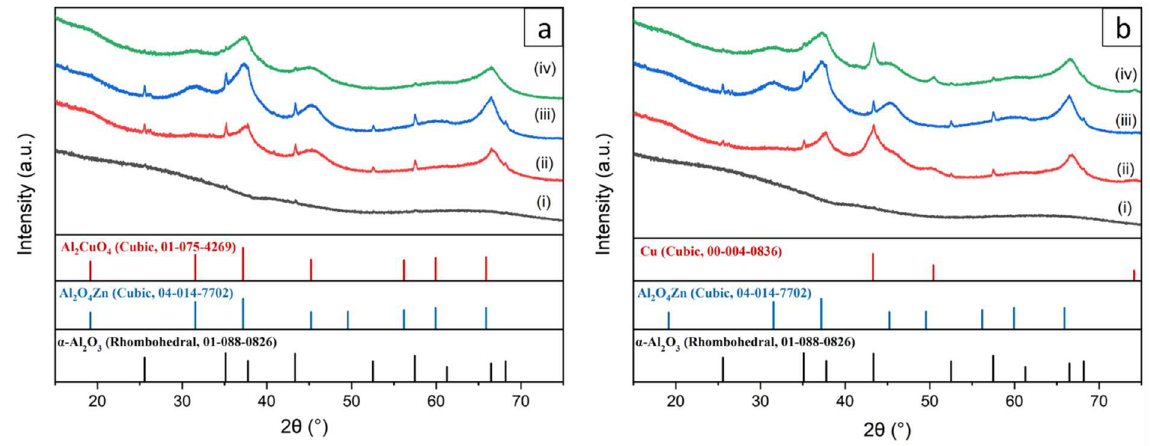
Figure 2. XRD patterns of ( a ) fresh and ( b ) reduced samples. (i)—(gray curve) AlNFs, (ii)—(red curve) AlNFs decorated by 10 wt% Cu (catalyst AlNFs-10-Cu), (iii)—(blue curve) Al-O NFs decorated by 10 wt% Zn (catalyst AlNFs-10-Zn), and (iv)—(green curve) AlNFs decorated by 10 wt% Zn&Cu in a wt. ratio of 2.3 Zn/Cu (catalyst AlNFs-10-1Cu2.3Zn).